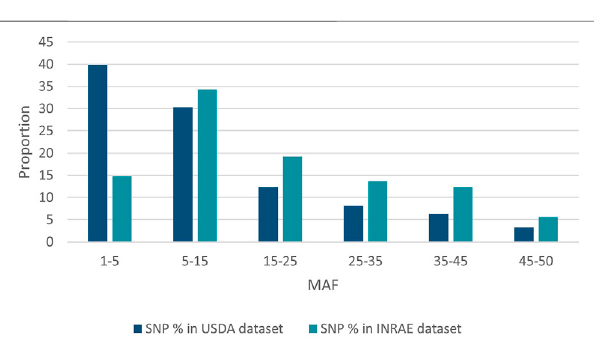
FIGURE 4 | MAF distribution of USDA or INRAE SNP datasets. These datasets have been fi ltered to keep bi-allelic SNP with a minimal MAF > 1% in their respective